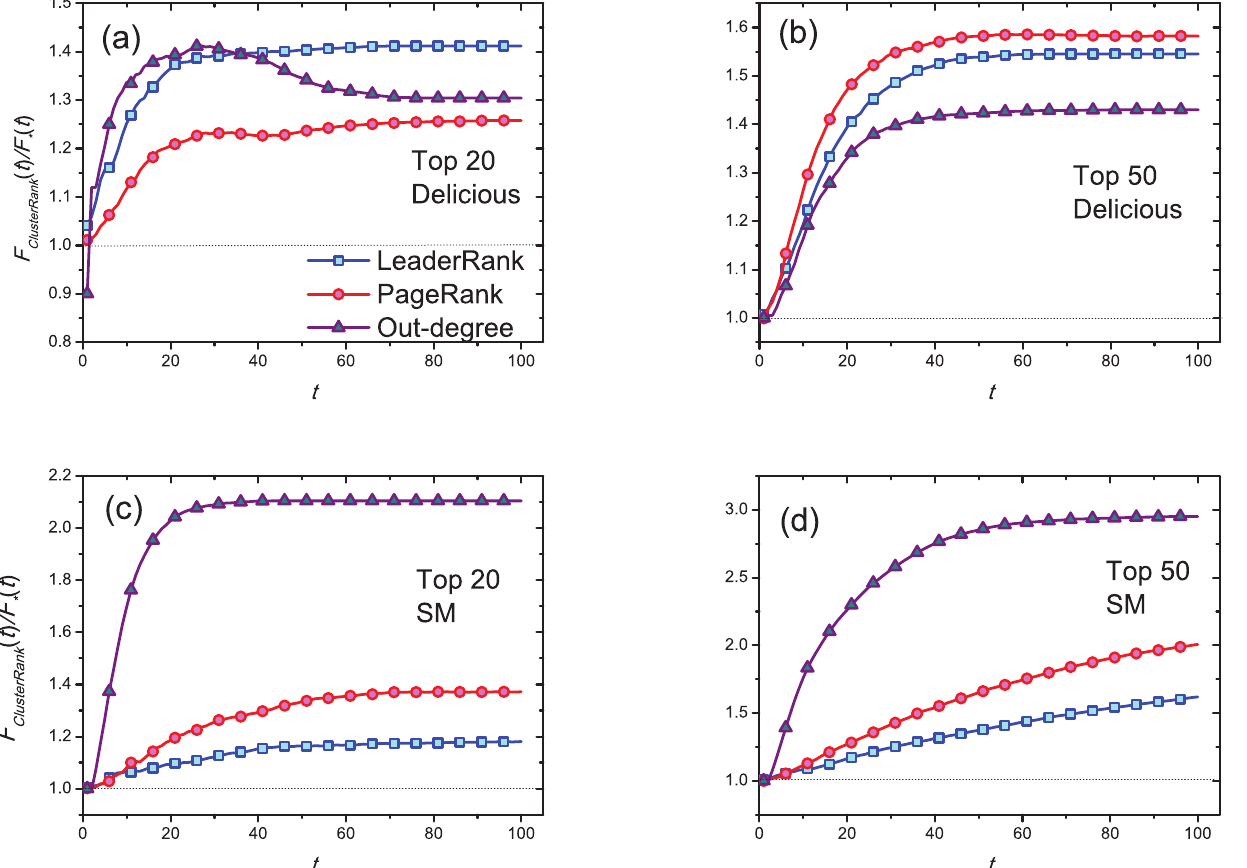
Figure 5. The ratio of the number of infected and recovered nodes by ClusterRank to those by out-degree centrality, PageRank and LeaderRank. Initially only non-overlapped nodes in the top- L lists obtained by ClusterRank and other ranking algorithms are set to be infected. We set l ~ 1 : 2 and b ~ 1 = S k out T . Each data point is obtained by averaging over 100 independent runs.